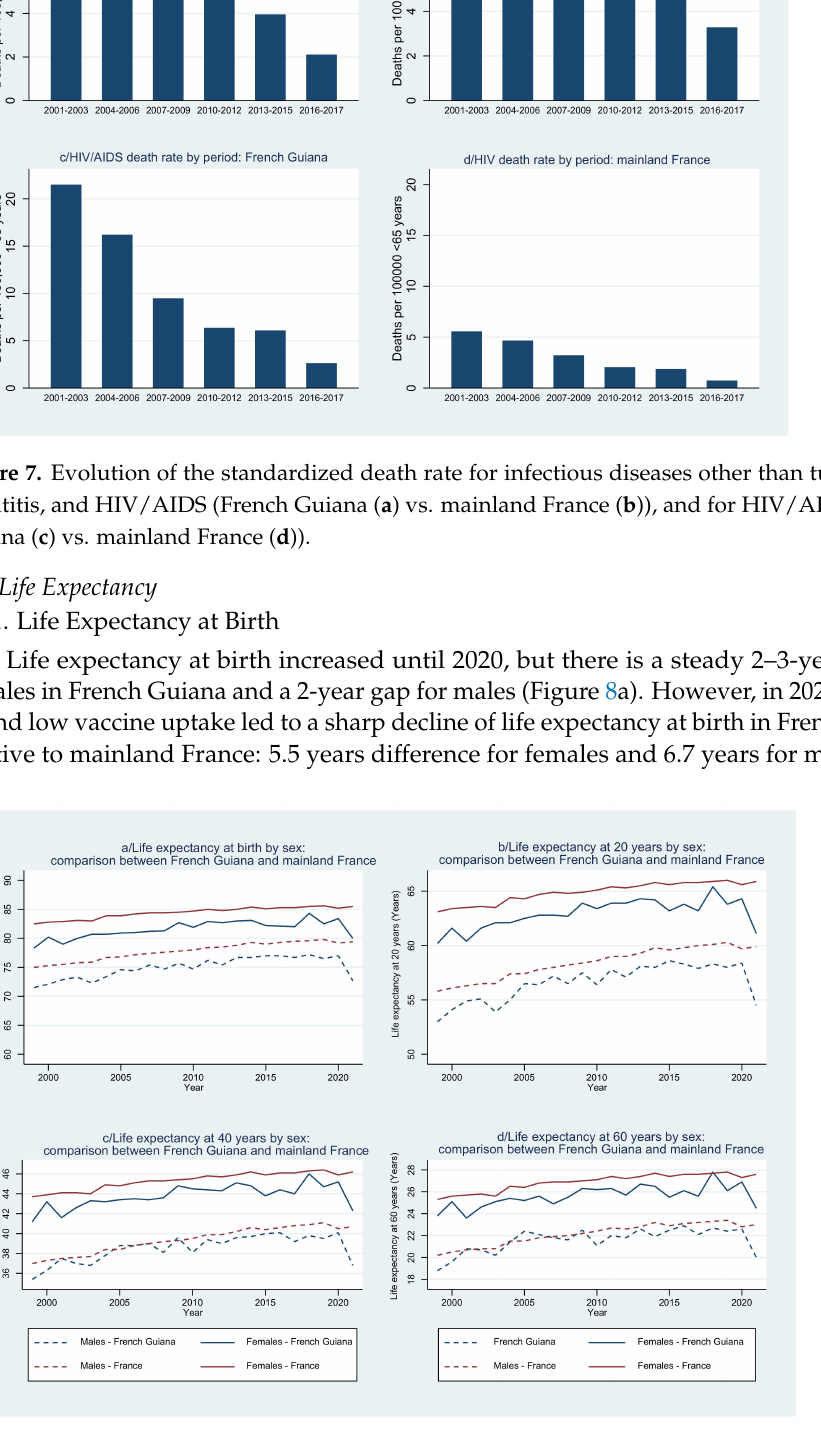
Figure 8. ( a – d ): Evolution of life expectancy by sex at birth ( a ), at 20 years ( b ), at 40 years ( c ), and at 60 years ( d ): French Guiana vs. mainland France. The y axis represents the number of years one could expect to live at birth, 20 years, 40 years, and 60